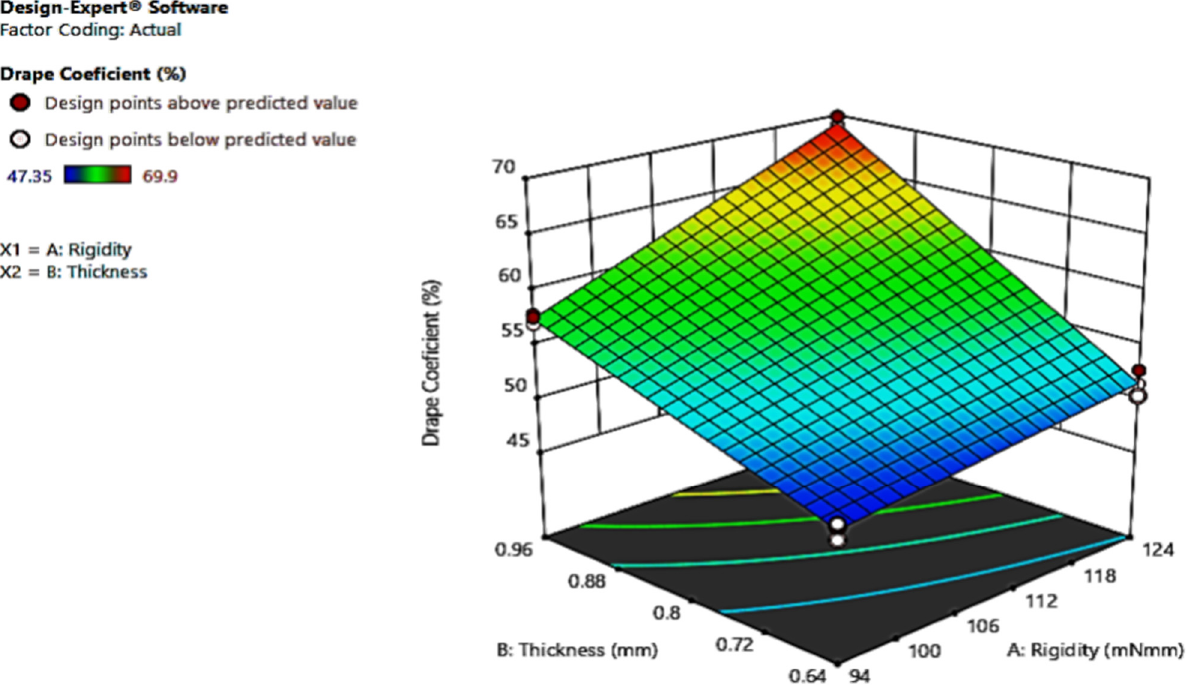
Figure 4. The three-dimensional interaction graph.